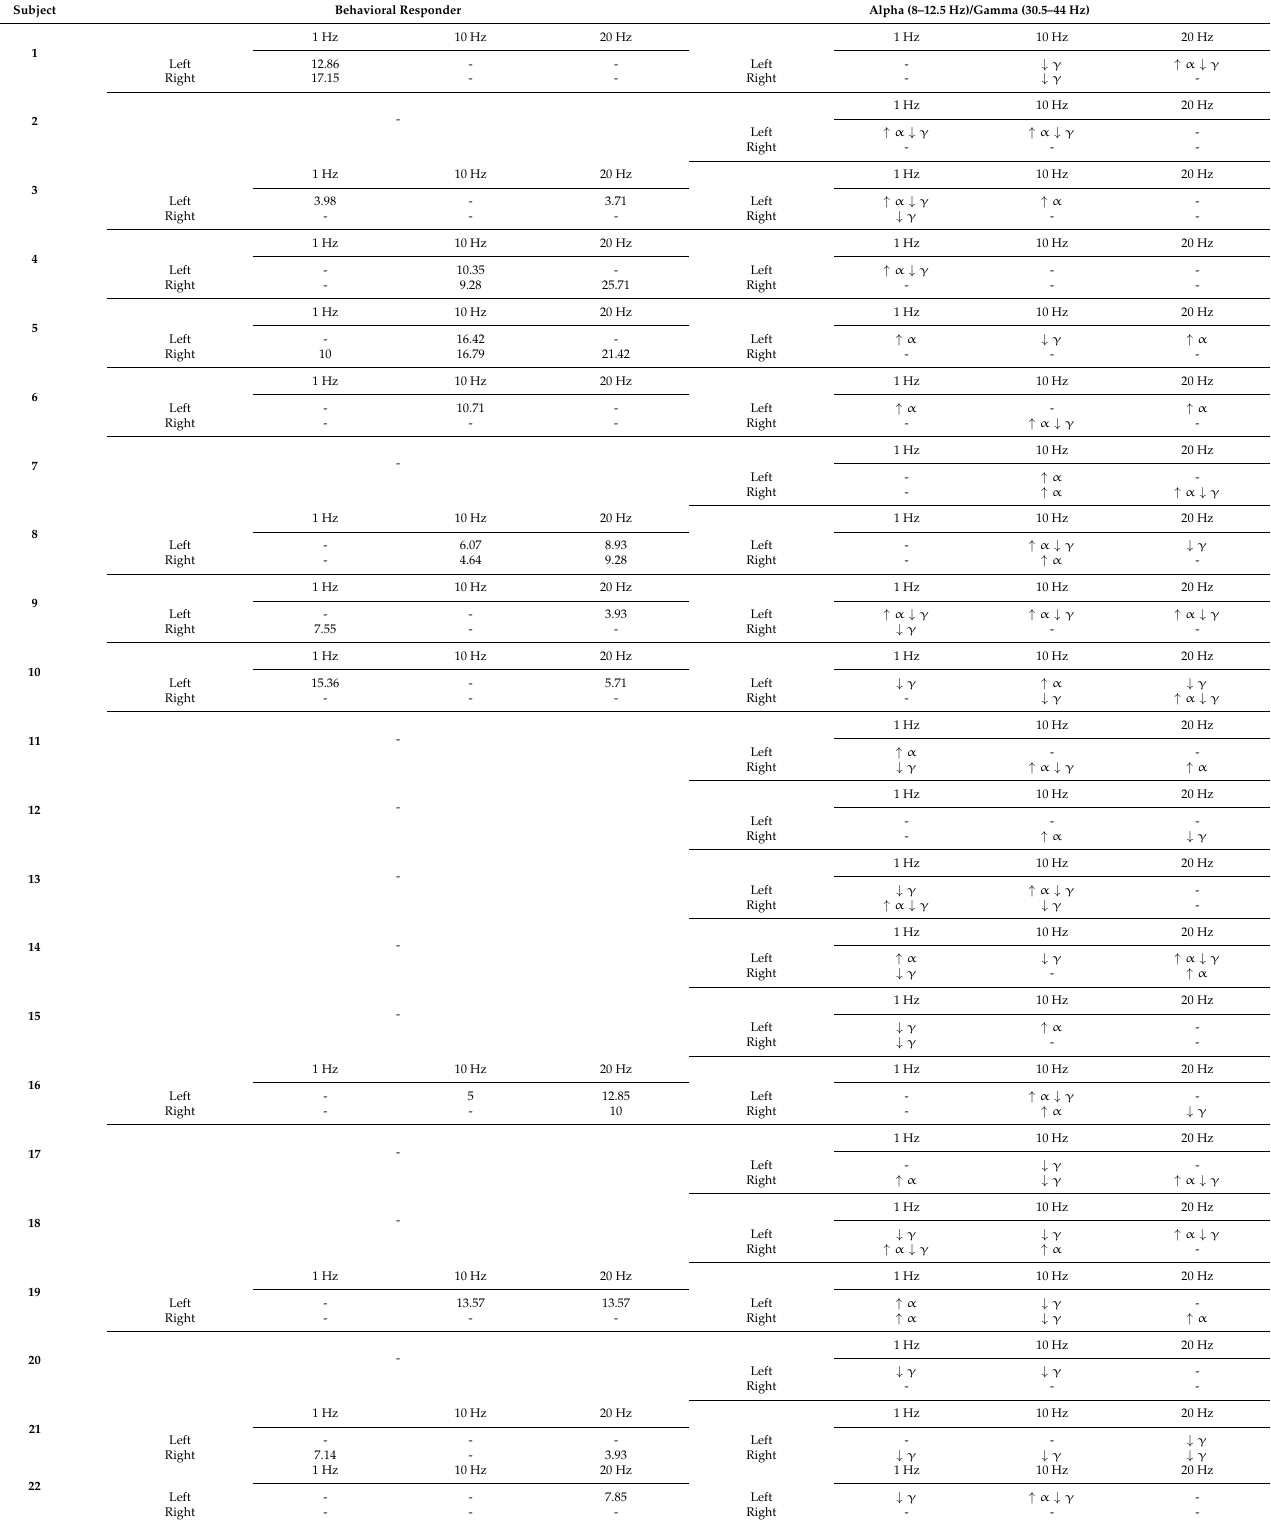
Table 2. Individual test session responses per protocol—behavioral and EEG